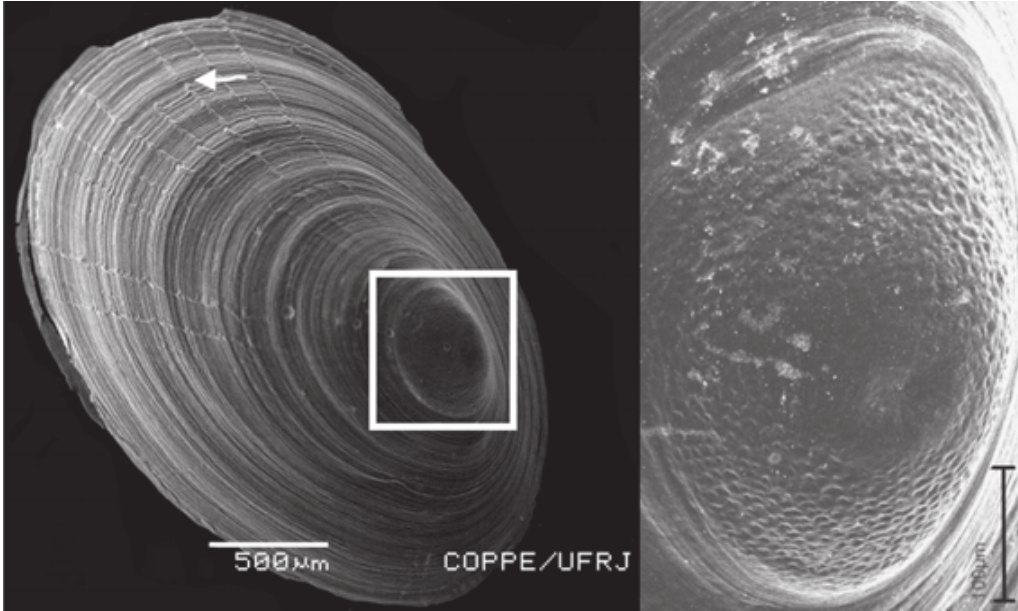
Figure 2. Gundlachia ticaga shell. Left side. Arrow: radial lines on the teleoconch. Square: protoconch area. Right side. Detail of the protoconch showing the irregularly arranged